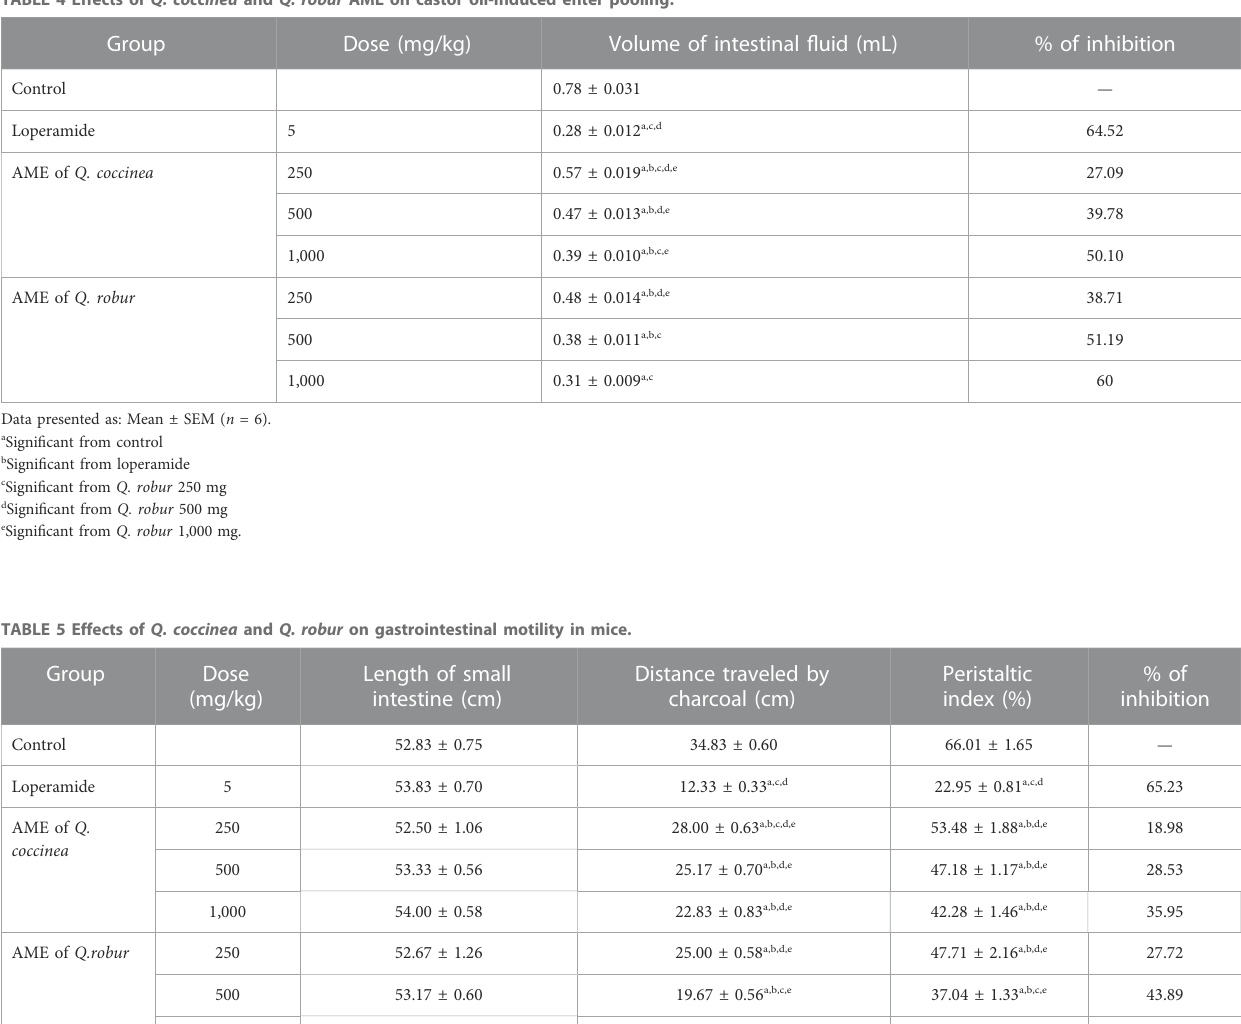
TABLE 4 Effects of Q. coccinea and Q. robur AME on castor oil-induced enter pooling. Group Dose (mg/kg) Volume of intestinal fl uid (mL)